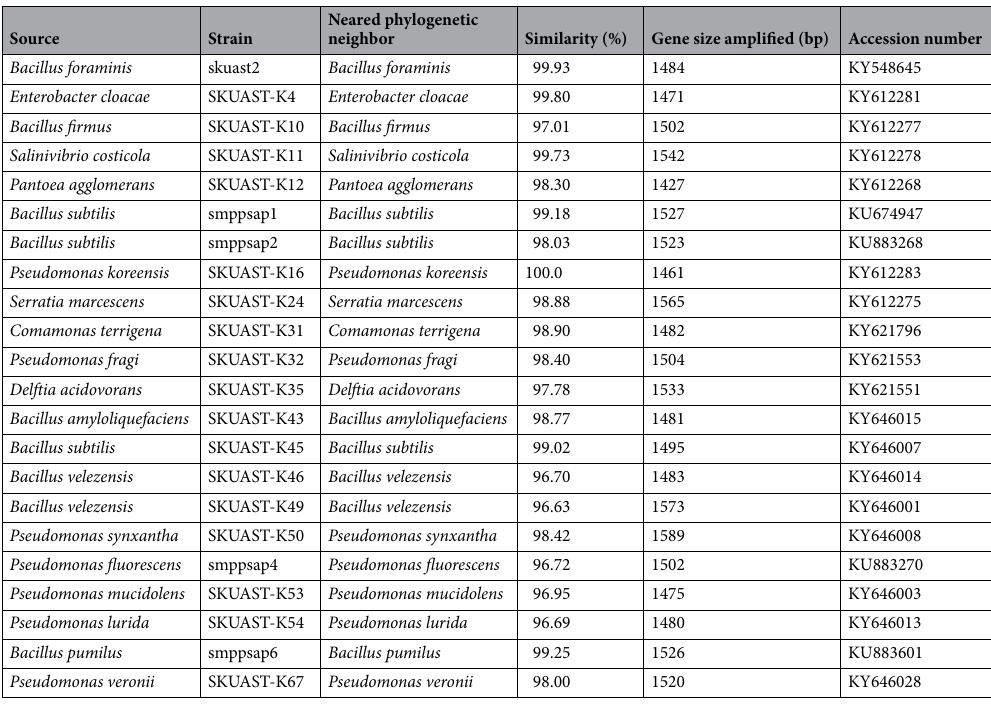
Table 3. Molecular facets of isolated microflora based on data retrieved from National Center for Biotechnology Information, USA.